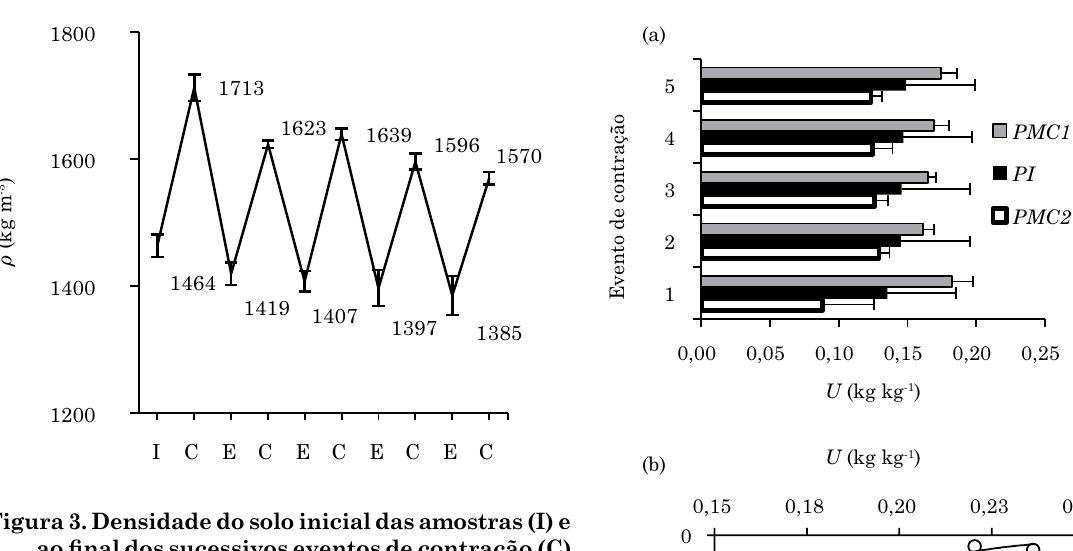
Figura 3. Densidade do solo inicial das amostras (I) e ao final dos sucessivos eventos de contração (C) e de expansão (E). Barras verticais representam o